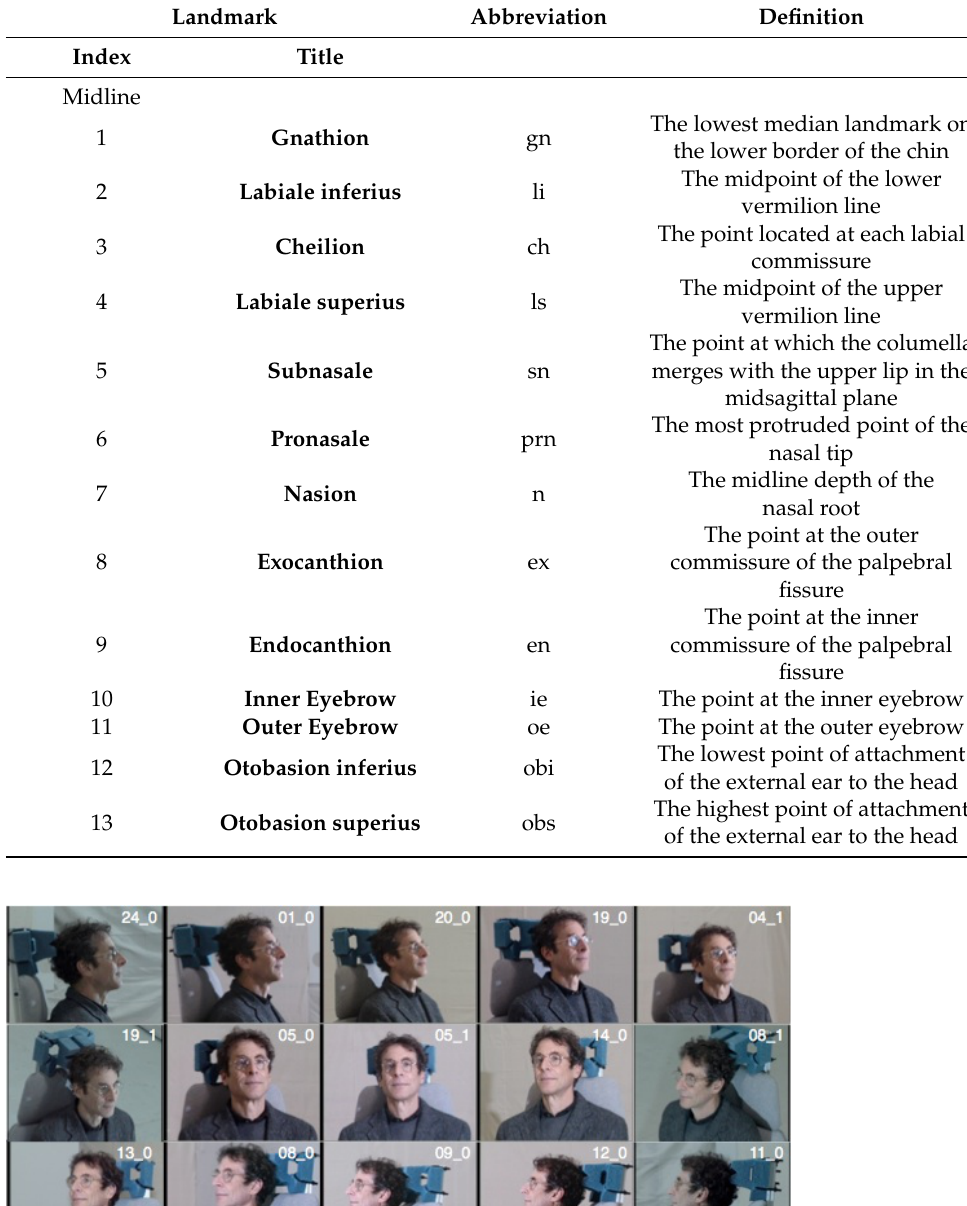
Table 2. Side pose facial landmark index numbers and definition [2,7,20,53].